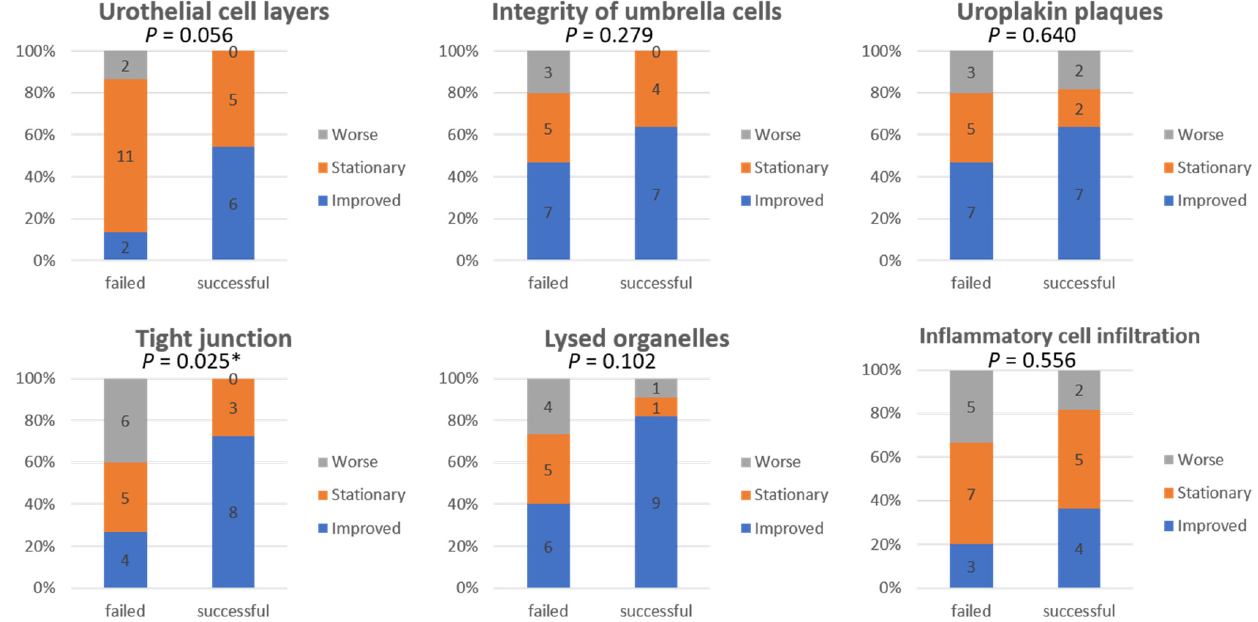
Figure 4. Changes in ultrastructural urothelial defects after the 4th platelet-rich plasma injection between interstitial cystitis/bladder pain syndrome patients with different treatment outcomes (failed vs. successful). * Significant difference, p < 0.05.